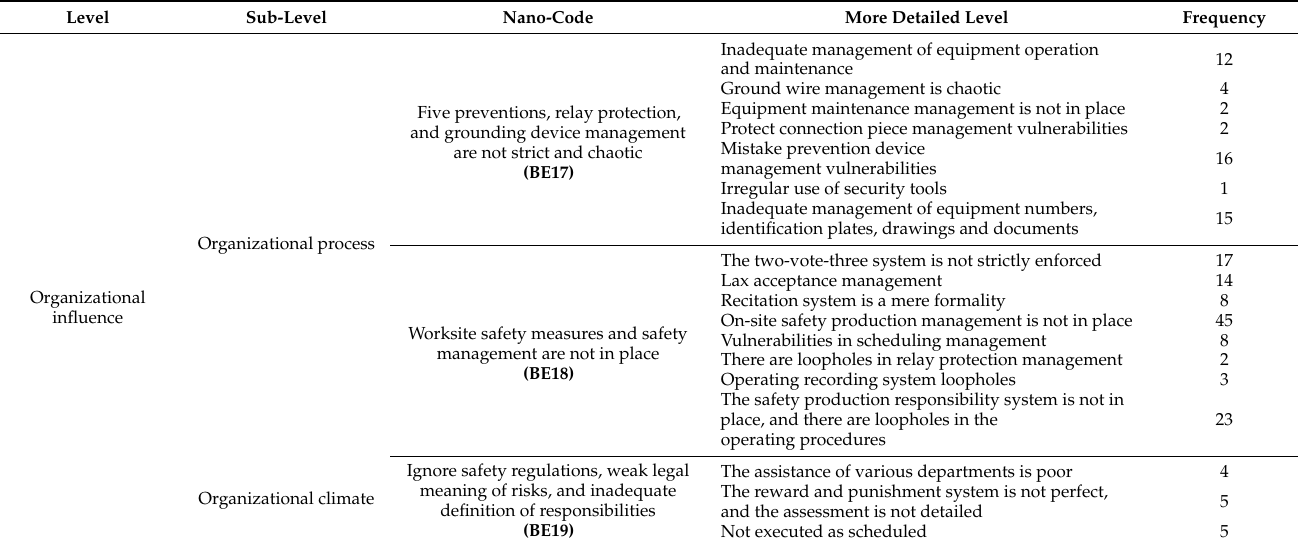
Table A1. HFACS–EMAs framework hierarchy of identified human and organizational